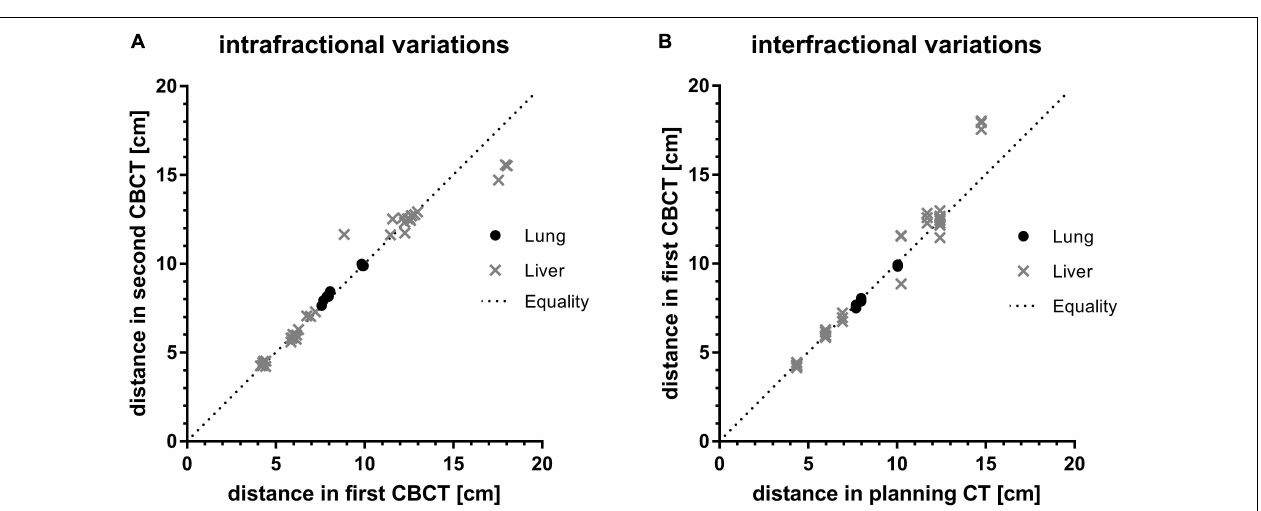
FIGURE 3 | Assessment of (A) intra-and (B) interfractional variations by comparison of absolute distances between a breathing independent point to a breathing dependent movable point of first compared to second CBCT and of planning CT compared to first CBCT for every fraction, respectively. Values are grouped by target location. The dotted line indicates theoretical equality of distances in